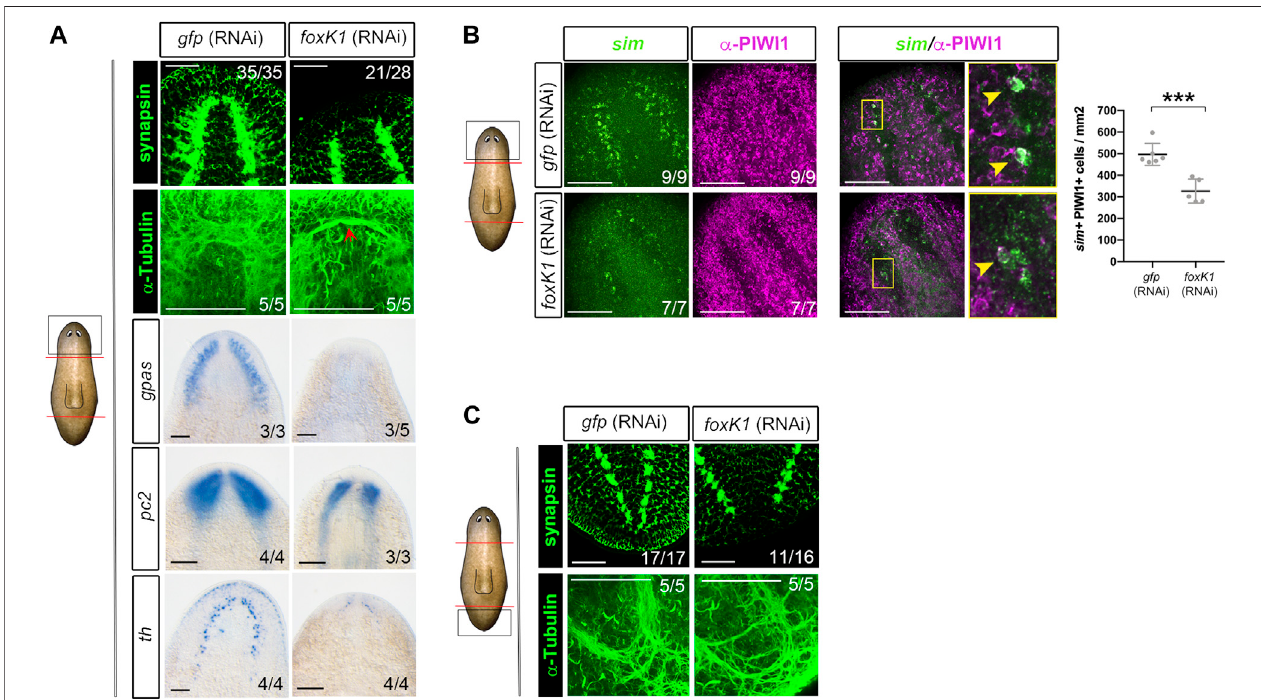
FIGURE 2 | foxK1 silenced animals show a reduced number of neural progenitors and almost absent differentiated neural structures. (A) Whole-mount immunostaining and in situ hybridization analyses (WISH) of the anterior nervous system regeneration in foxK1 RNAi animals 7 days post amputation. From top to bottom: immunostaining of the brain ganglia visualized with anti-synapsin which labels the brain synapsis; Immunostaining of the brain ganglia visualized with anti- α - tubulin which labels axons; WISH of gpas, pc2 and th which label differentiated neural cells. Scale bar: 100 µm. (B) Whole-mount fl uorescence in situ hybridization analysis (WFISH) combined with immunostaining of the anterior blastemas in foxK1 RNAi animals 7 days post amputation. From left to right: WFISH with sim, which labels both neural progenitors and differentiated neurons; immunostaining with anti-PIWI1 which labels stem cells; double sim+/ PIWI1+ positive cells, which indicate neural progenitors; Scale bar: 100 µm. Quanti fi cation of sim + PIWI + cells/mm2 reveals a decreased number of neural progenitors in foxK1 RNAi animals. Values represent the mean ± standard deviation [s.d] of a mean of 5 samples per condition. *** p -value < 0.001. (C) Whole-mount immunostaining analysis of the posterior nervous system regeneration in foxK1 RNAi animals at 7 days post amputation. From top to bottom: anti-synapsin labelling the synapsis and anti- α -tubulin labeling the axons, showing defects in the posterior VNCs. Scale bar: 100 µm. In the schematic planarians, red lines indicate the amputation planes and black squares the region